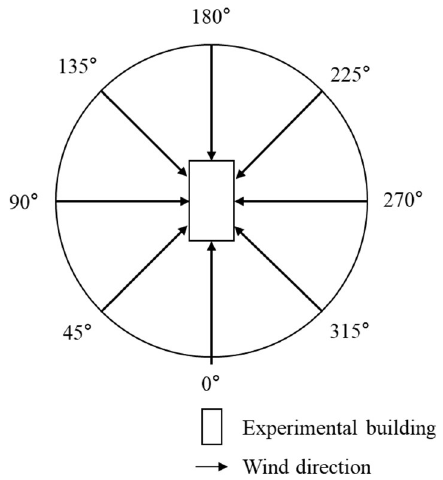
Figure 8. Definition of wind direction at the experimental building